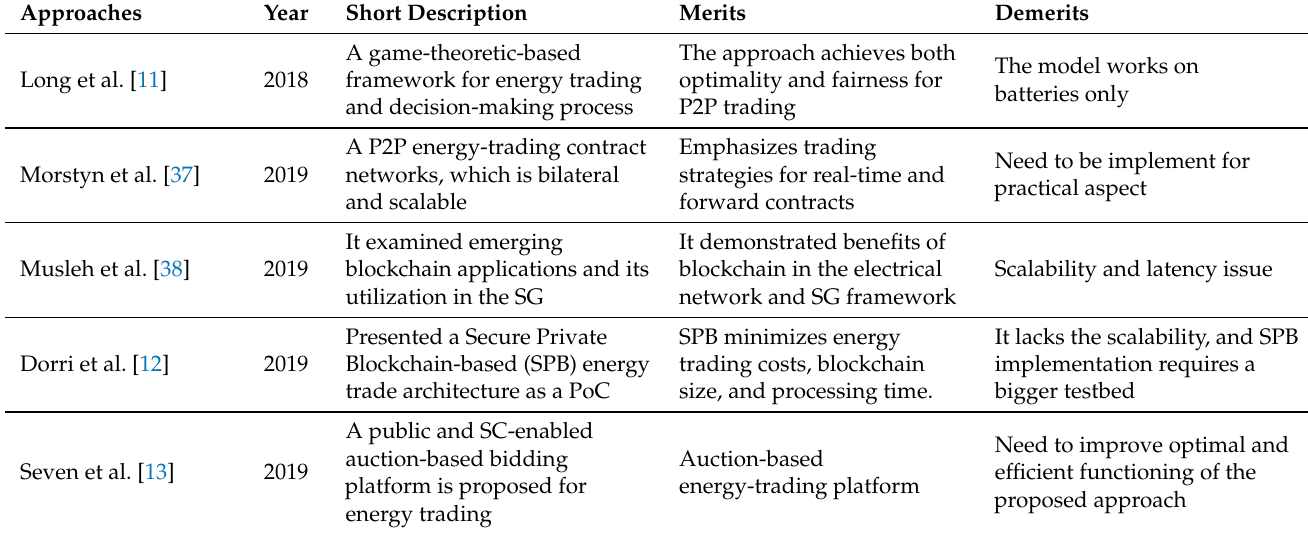
Table 1. A comparative analysis of the proposed DT-P2PET scheme with the existing